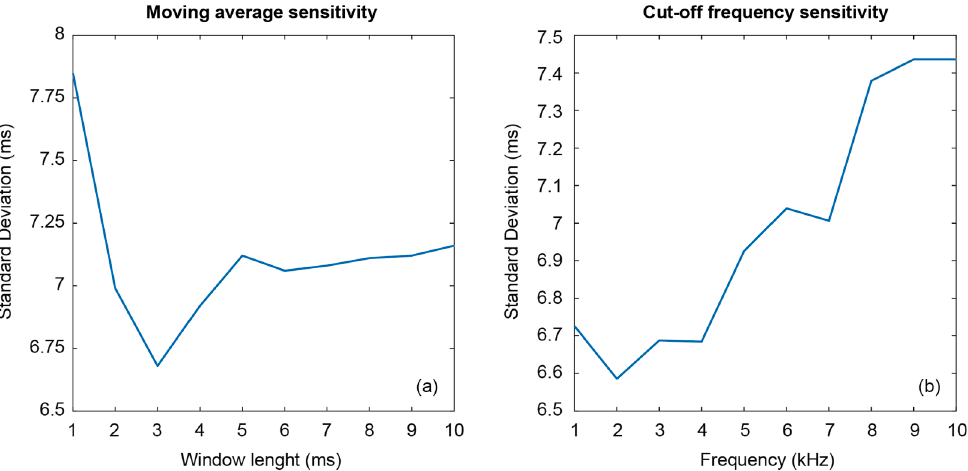
Figure 4. Algorithm sensitivity as a function of ( a ) moving average length and ( b ) cut-off frequency.